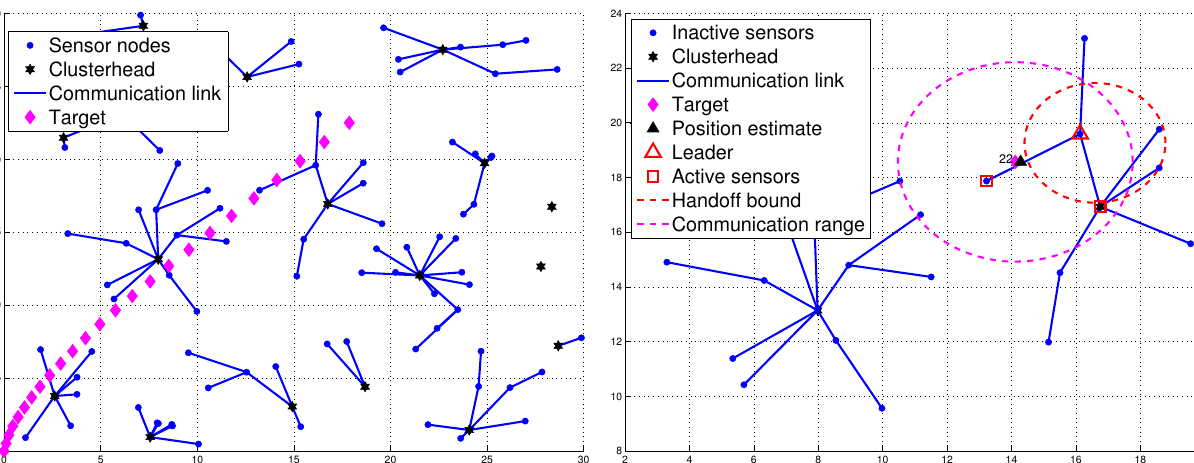
Figure 2. The cluster-based network topology and target movement with 25 time steps ( left ); an example of leader and sub-cluster member selection ( right